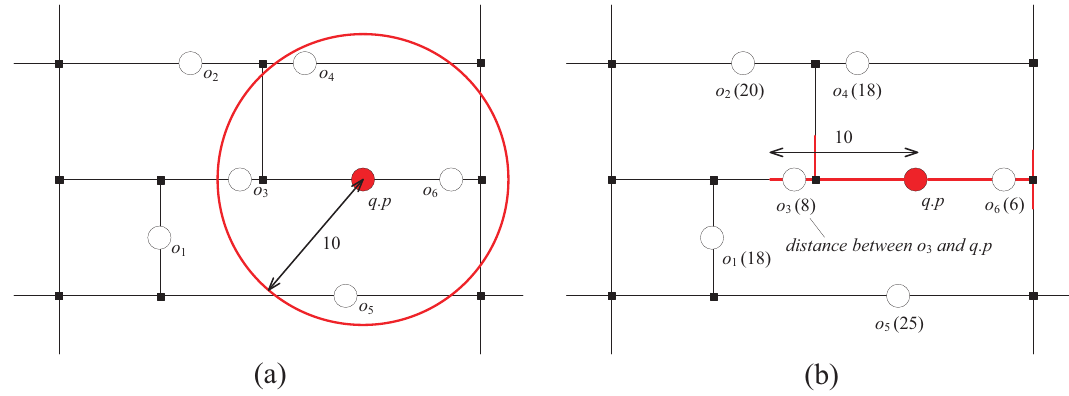
Figure 1. Difference between Euclidean space and the road network. ( a ) The query range in Euclidean space; ( b ) The query range in the road